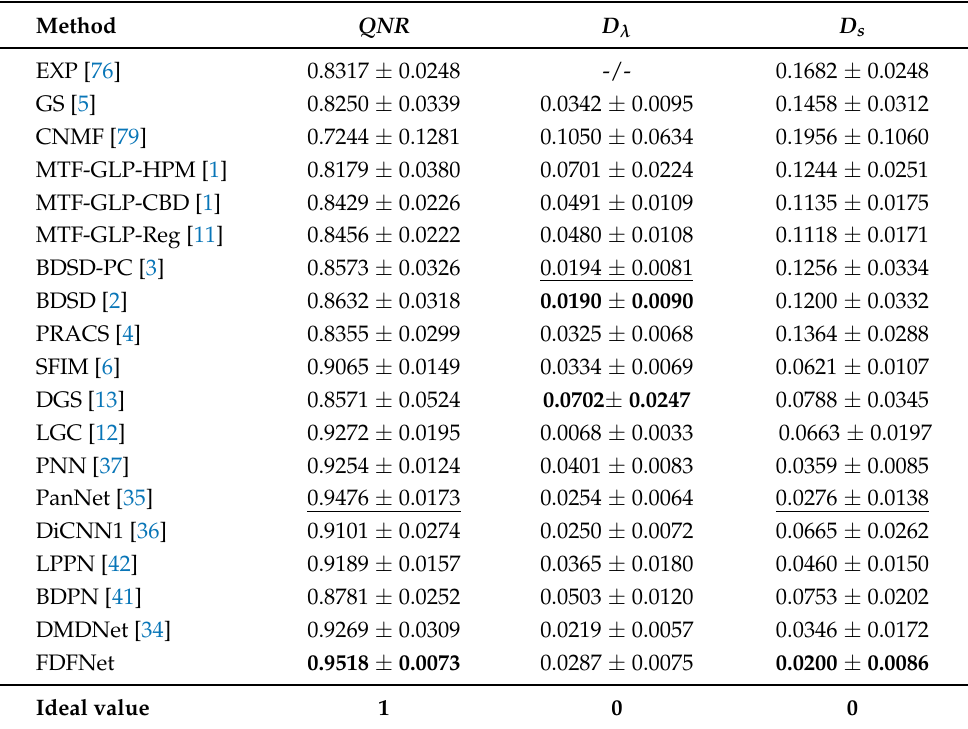
Table 6. The average quantification compared to the relative standard deviation (std) of 100 full- resolution QB samples. The best performance is shown in bold and second place is underlined.